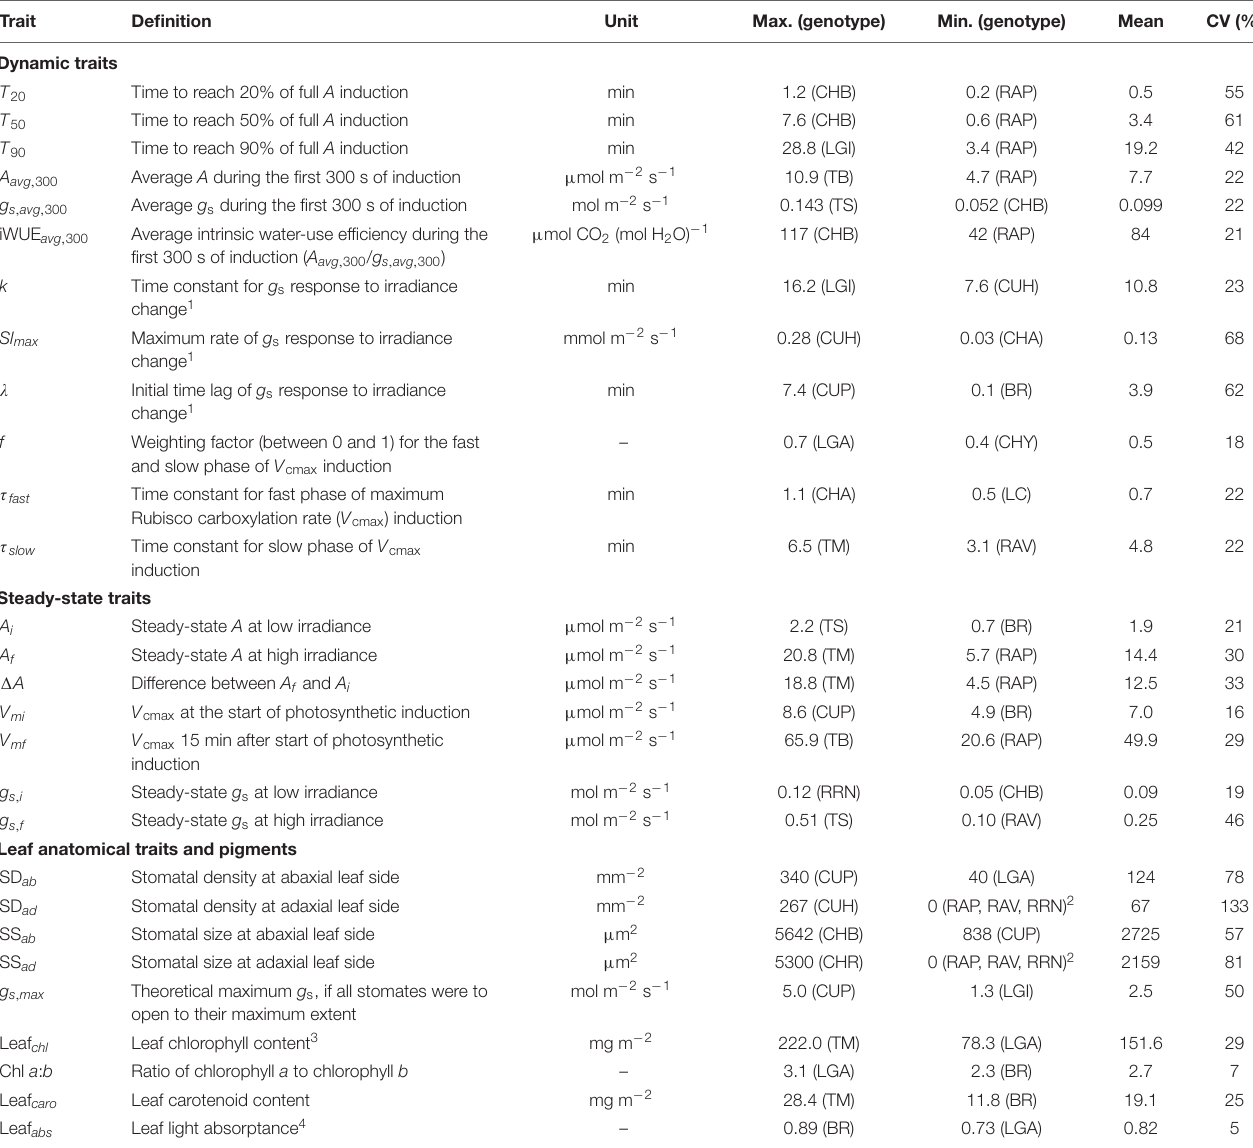
Maximum and minimum values are average values of 6–9 replicates. 1 Rose was excluded from estimations of k, Sl max , and λ , due to a lack of change between g s , i and g s , f . 2 Rose did not display stomata on the adaxial leaf side. 3 Sum of chlorophyll a and chlorophyll